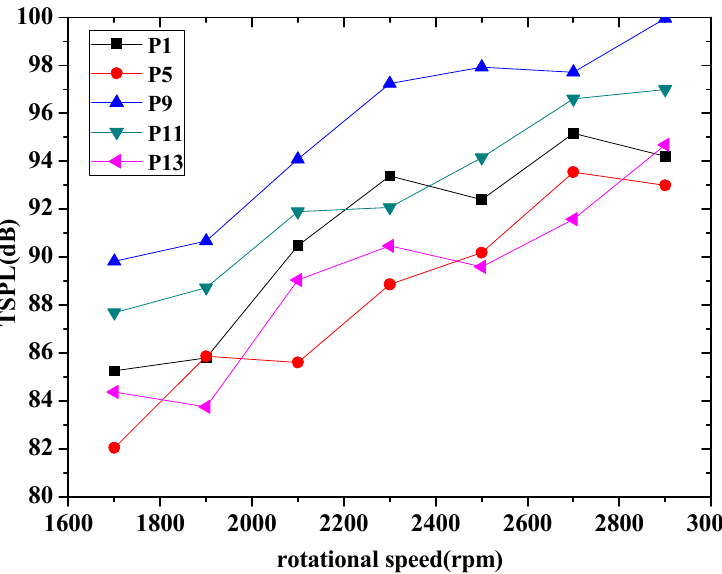
Figure 7. TSPL changing curves with rotational speed.